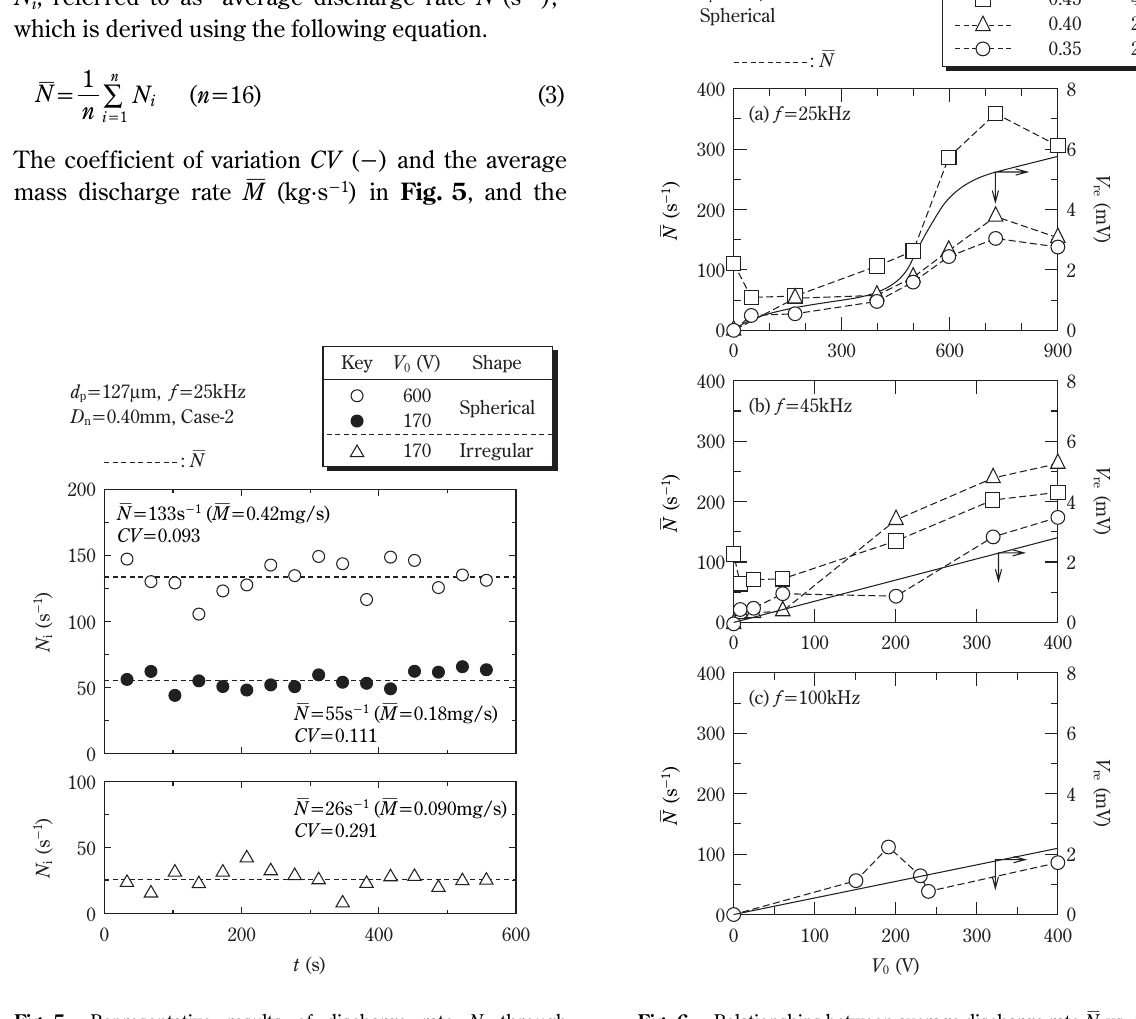
Fig. 5 Representative results of discharge rate N i through elapsed time